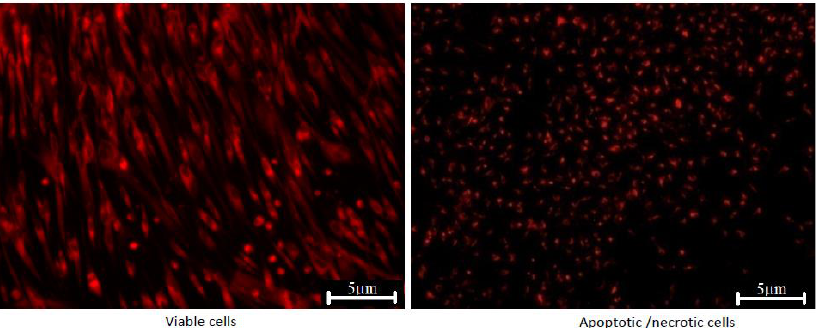
Figure 12. Fluorescent microscopy images of cerium-doped HAp powders (viable cells) and negative control sample.